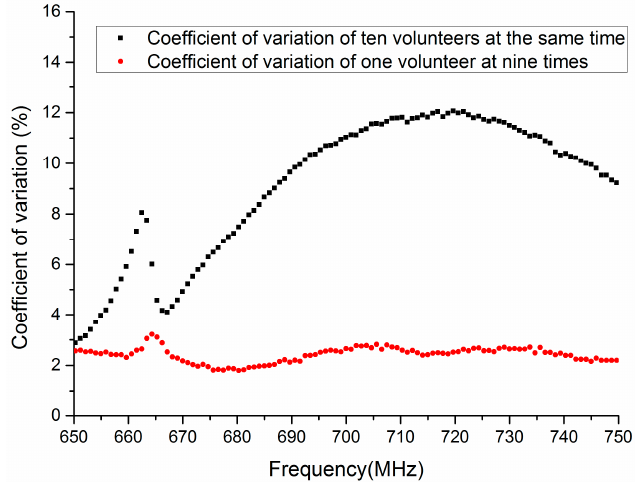
Figure 7. The coefficient of variation of transmission gain S21 in the frequency range 650 MHz to 750 MHz.